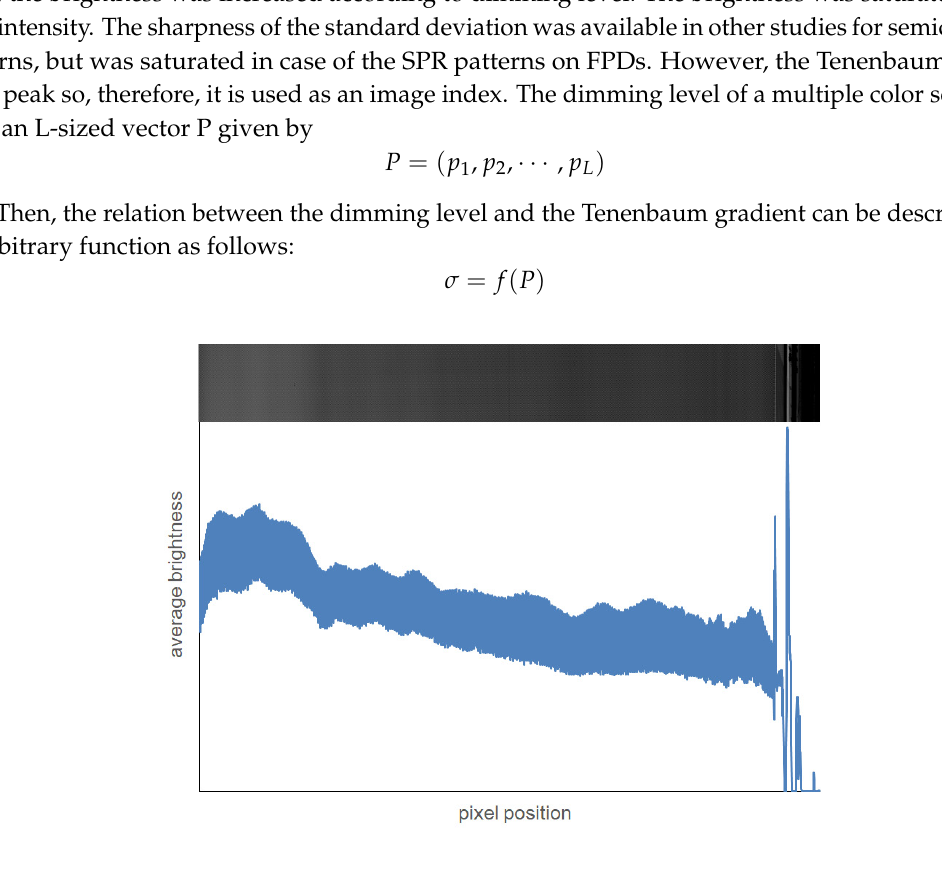
Figure 2. Non-uniformity of brightness in a raw image after